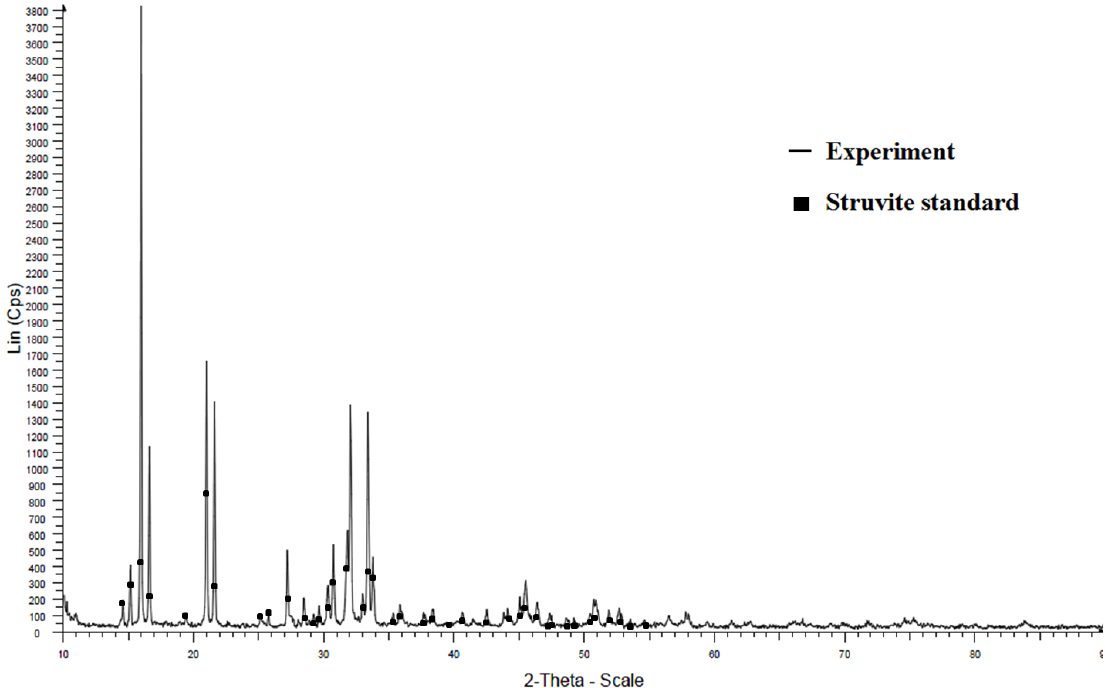
Figure 5. X-ray diffraction patterns of struvite